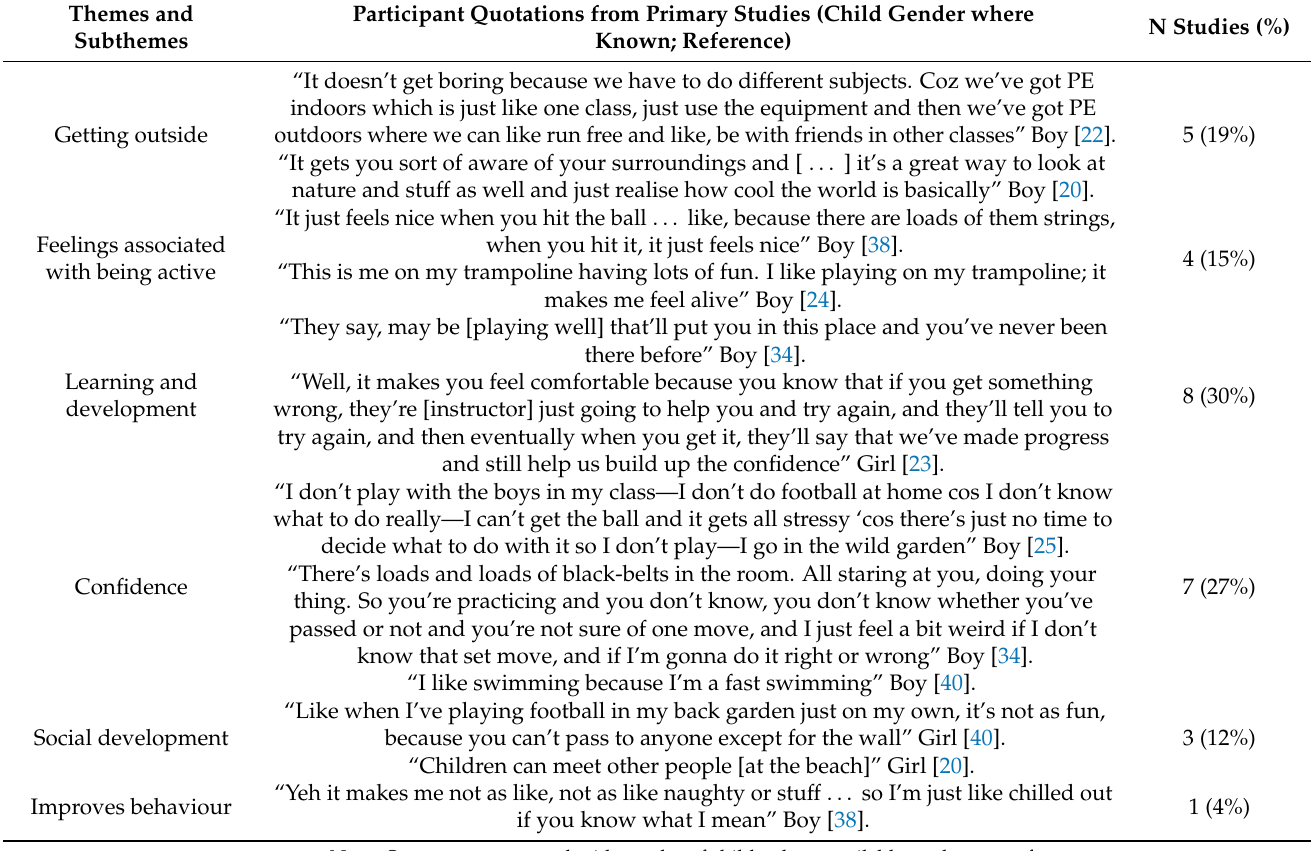
Table 5. Illustrative quotations and references reporting each of the subthemes for ‘What are